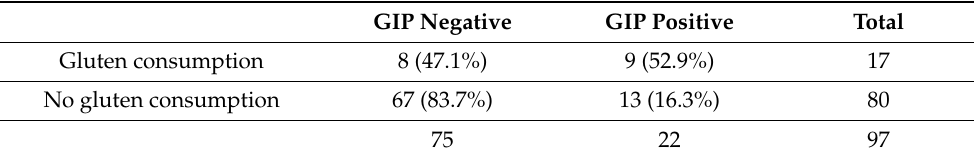
Table 4. Relationship between detection of gluten immunogenic peptides (GIPs) in stool and patient self-reported gluten consumption in the last month before gastroscopy was performed. GIP Negative GIP Positive Total Gluten